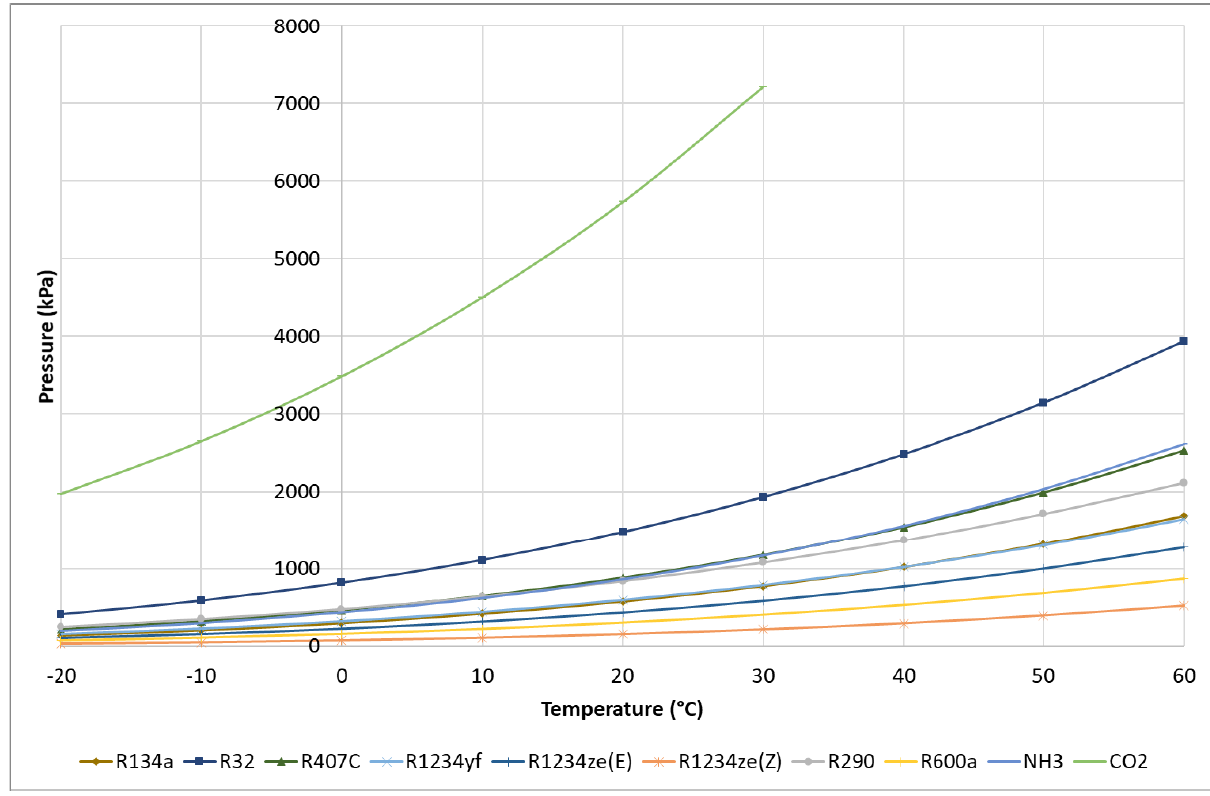
Figure 8. Comparison of P-T diagrams.